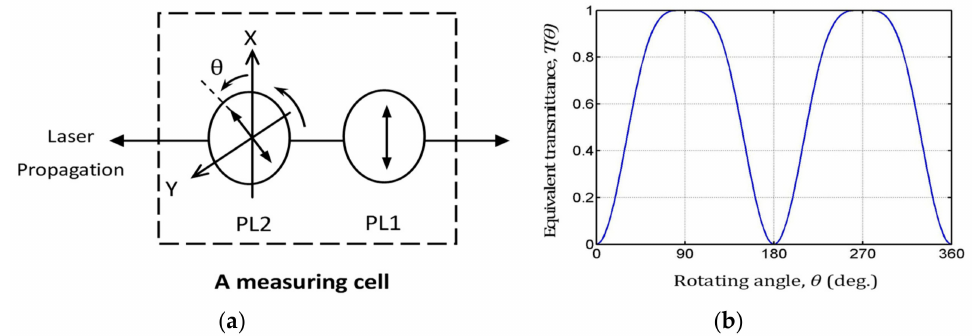
Figure 1. Schematic of the measurement cell and the equivalent transmittance T ( θ ) curve. ( a ) Schematic of the measurement cell. ( b ) The equivalent transmittance T ( θ ) of the measurement cell as a function of the rotating angle θ .